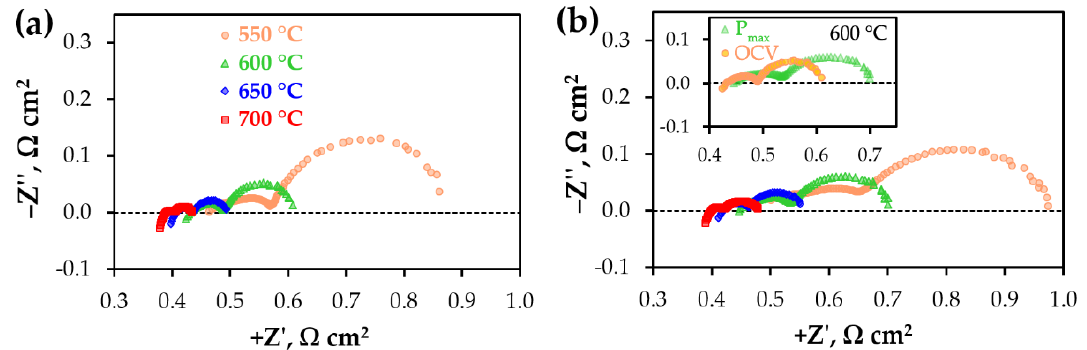
Figure 4. Typical impedance spectra of the fabricated PCFC at di ff erent temperatures under conditions corresponding to open circuit voltage (OCV) ( a ) and P max ( b ).